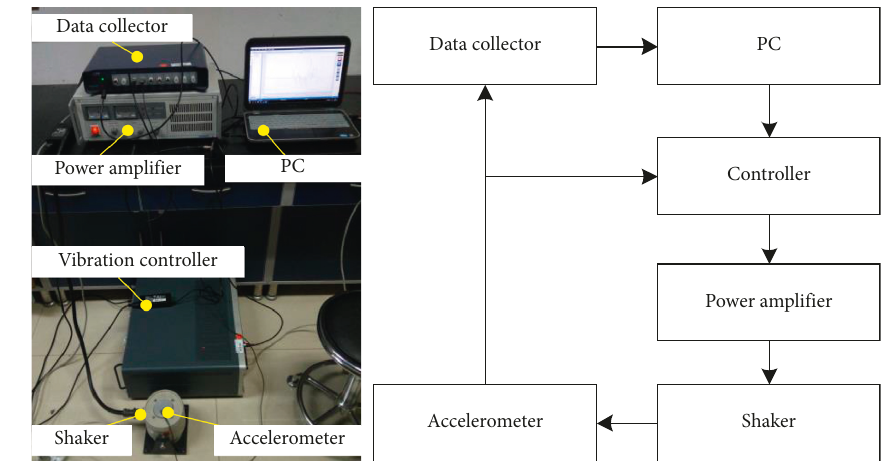
Figure 8: AVC system for SRS validation.